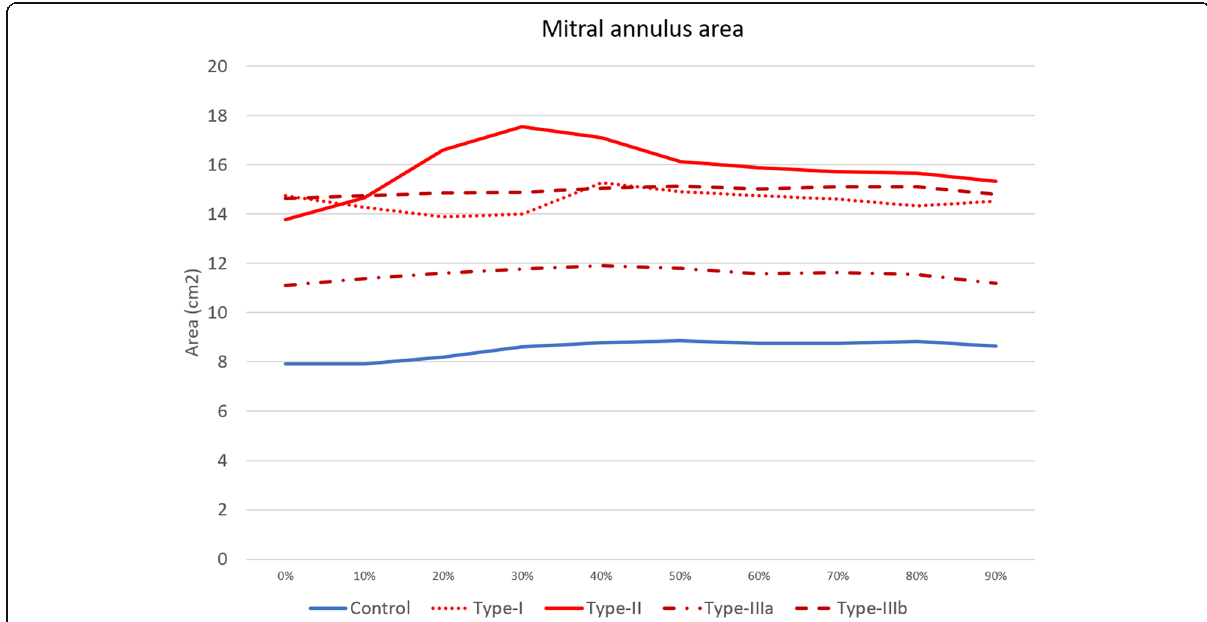
Fig. 6 Dynamic modifications of the mitral annulus area through the different phases of the cardiac cycle according to Carpentier classification of mitral regurgitation and in control patients